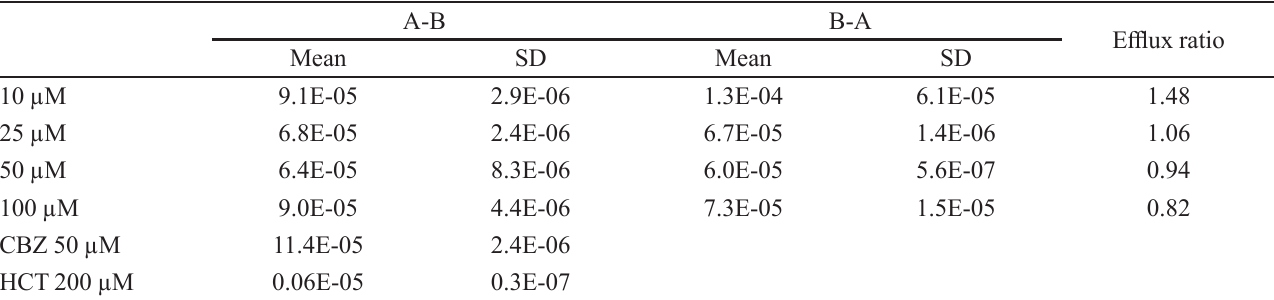
(cm/s) values for 6MC obtained in the absorptive (A-B), secretory (B-A) directions, and efflux ratio TABLE I - Comparable P app ( P B-A/ P app app